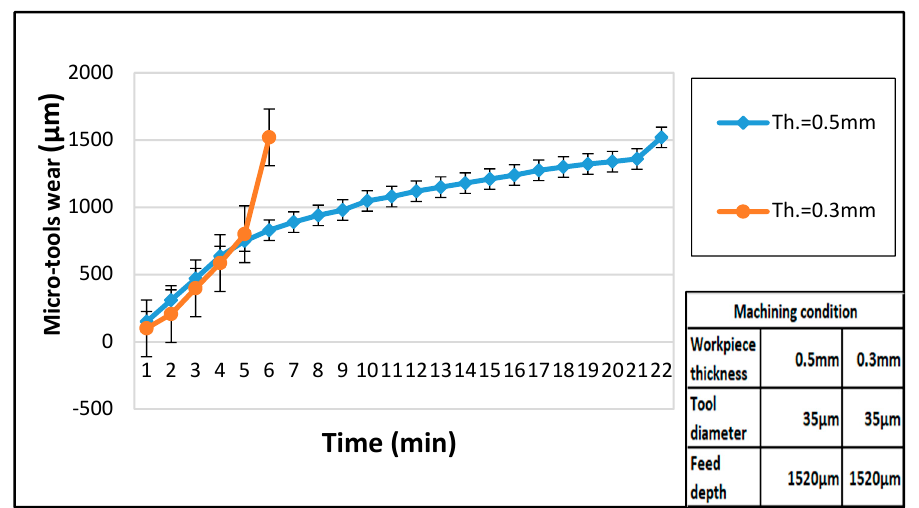
Figure 13. Micro-tools wear on WC-Co by the desktop micro-EDM.